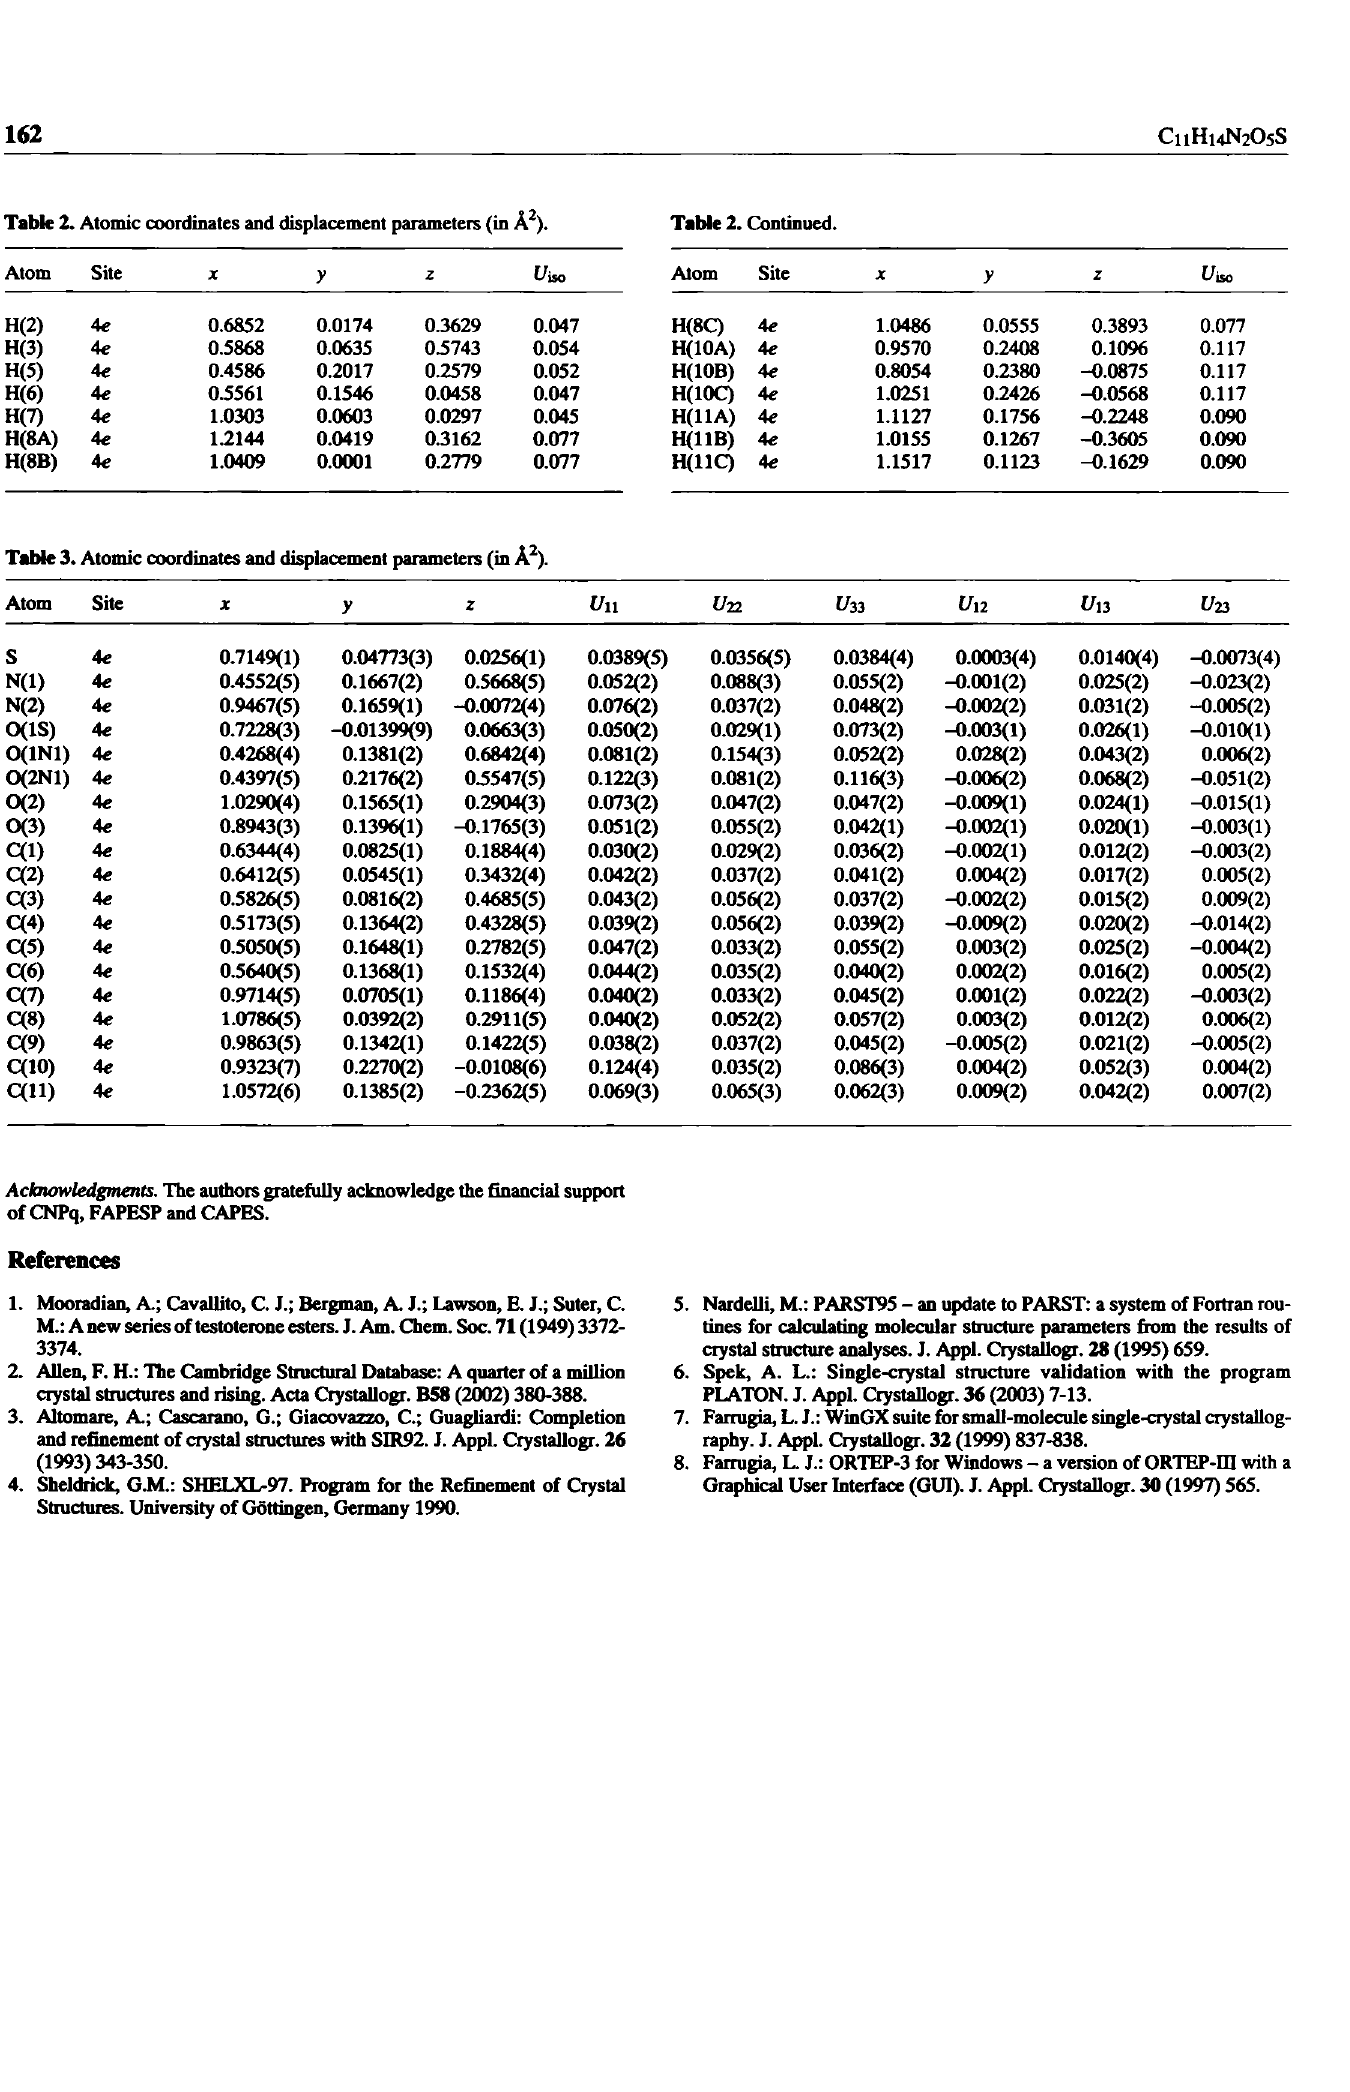
Table 3. Atomic coordinates and displacement parameters (in A 2